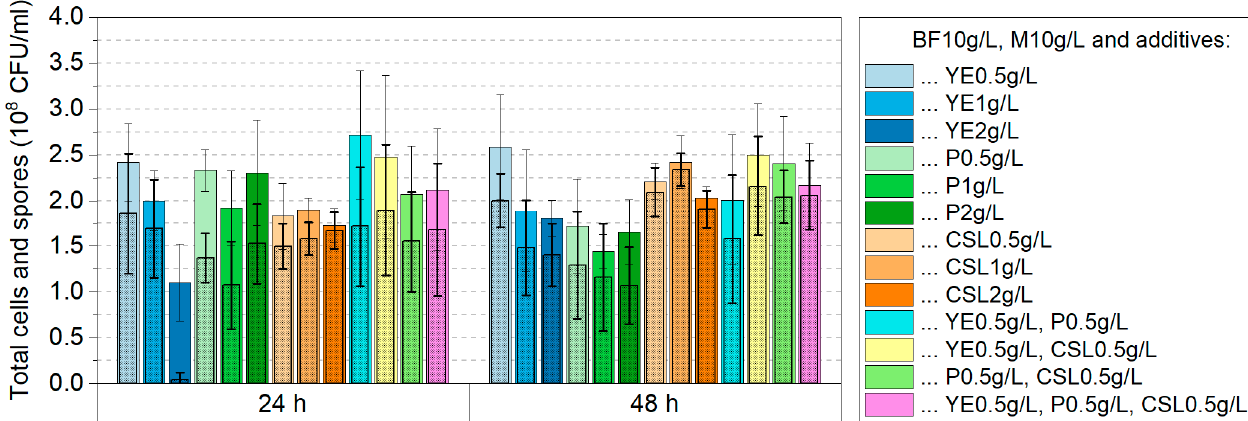
Figure 2. B. subtilis MSCL 897 cultivation in medium containing broad bean flour (BF) 10 g/L, molasses (M) 10 g/L and combinations of yeast extract (YE), peptone (P) and corn-steep liquor (CSL). Total cell (outer bars) and spore (inner bars) counts at 24 and 48 h.